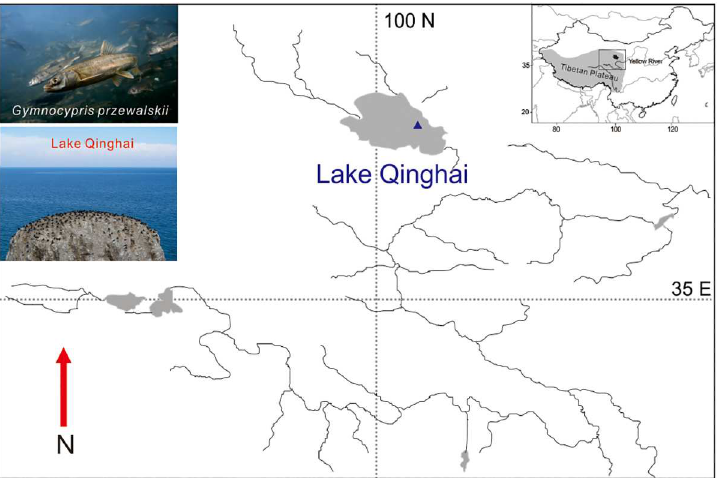
Fig 1. Sampling site and photos of G . przewalskii and Lake Qinghai. (a) The samplingmap was created using the ArcGIS v10.1 (ESRI, CA, USA) and Adobe Illustrator CS5 (Adobe Systems Inc., San